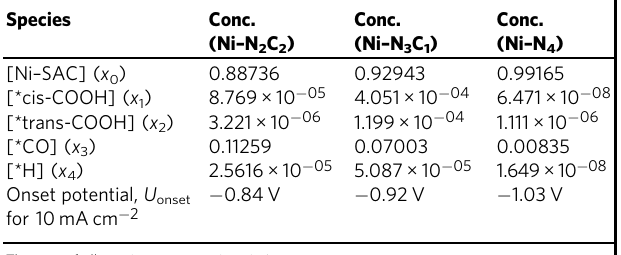
Table 1 Species concentration corresponding to the onset potential of each site at 298 K and pH =